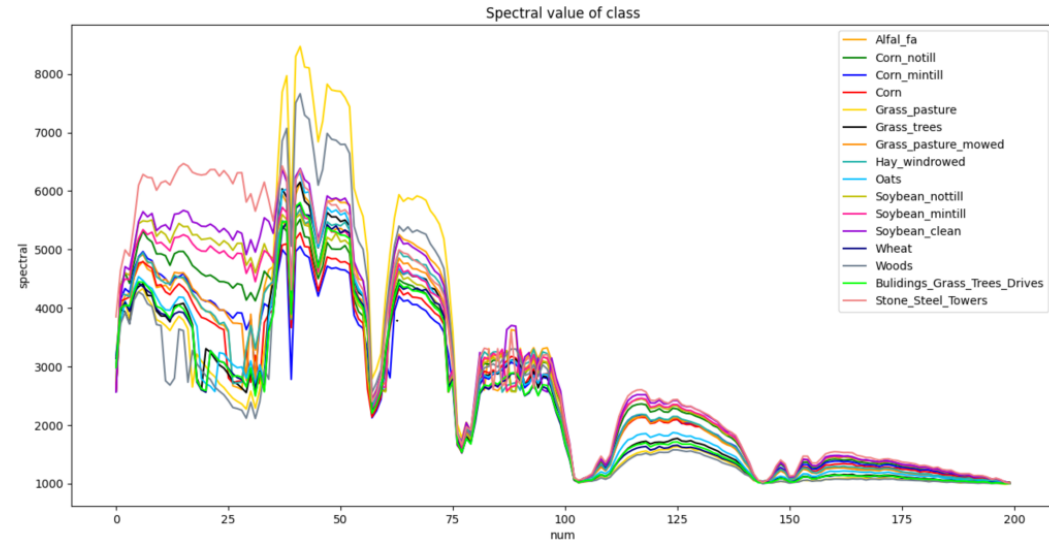
Figure 3. The spectral curves of 16 types of samples.